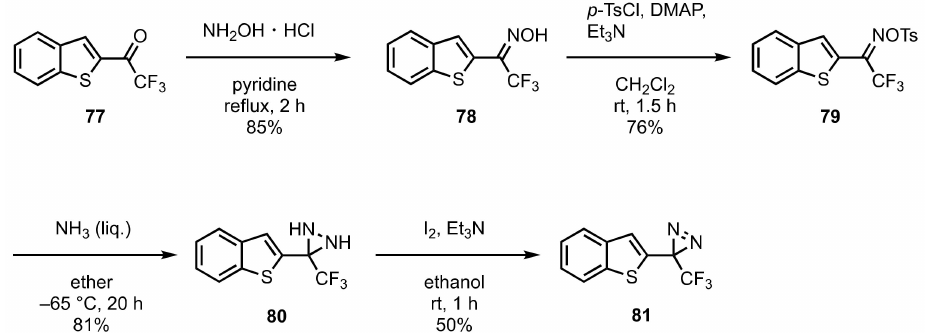
Scheme 11. The synthesis of diazirinyl-substituted thiophene analogue